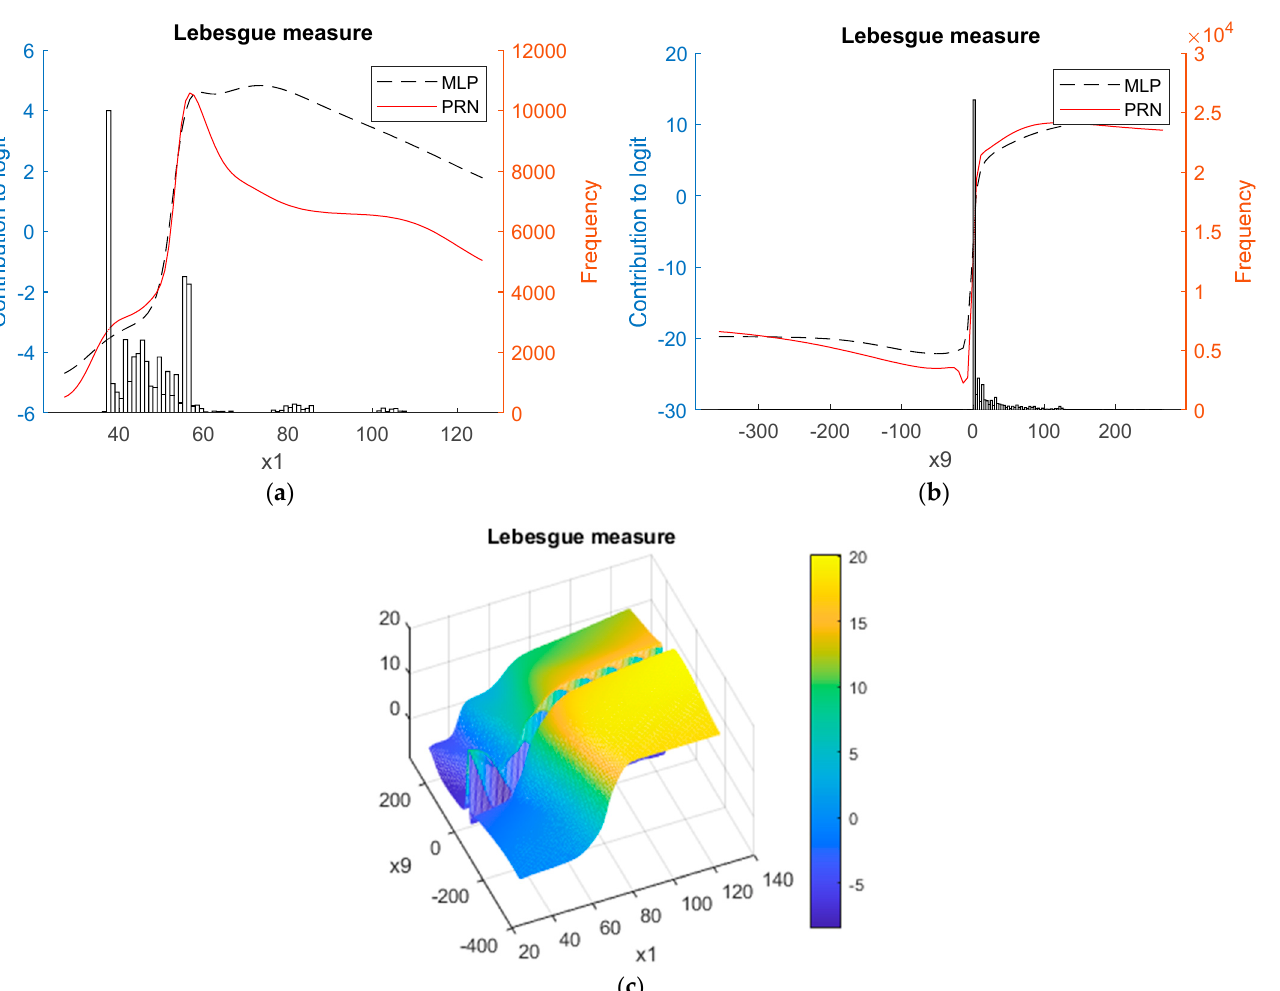
Figure 10. Nomogram of the PRN–Lasso model obtained for the Statlog Shu tt le data set using the Dirac measure with a training/test split of n = 43,500 and 14,500, respectively: ( a ) Shows the raw data for the two variables selected, which corresponds well with two partial responses in the fi nal model, namely: ( b ) shows the main e ff ect involving x 9 ; and ( c ) plots the two-way interaction between the two variables in the model, x 1 and x 9 .